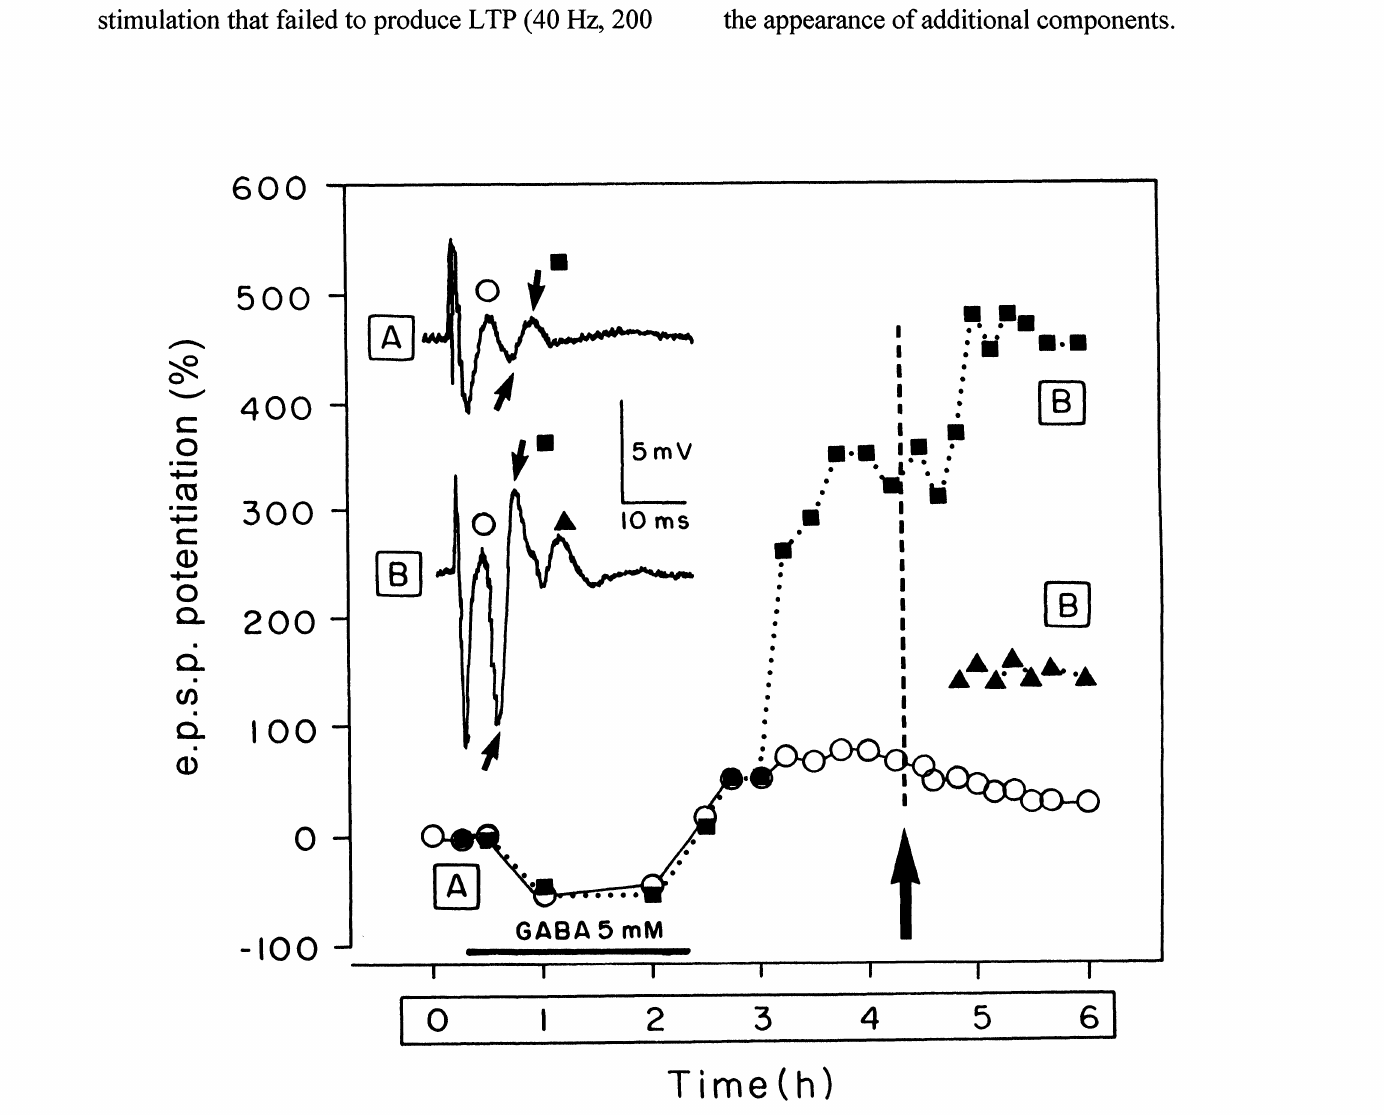
Fig. 3: In vitro induction of cortical GWS and the effects of electrical stimulation. Longitudinal brain slices (400 lam), obtained from anesthetized young adult (150 g) Wistar rats, were incubated for 60 min in Ringer-Krebs solution and then for 120 min in 5 mM GABA, followed by a wash. The graph plots the slope of the rising phase of the various components (indicated by symbols) of the population evoked response (e.p.s.p.), recorded from the superficial layers (I-II) of the cortex in response to test stimuli applied to the deep (V-VI) cortical layers. Each point represents the average of 10 responses. The first response is shown in empty circles, the second component, indicated by arrows, is illustrated with filled squares, and in triangles, a late component that appeared after GWS induction and electrical stimulation (40 Hz for 200 ms 10, at 0.2